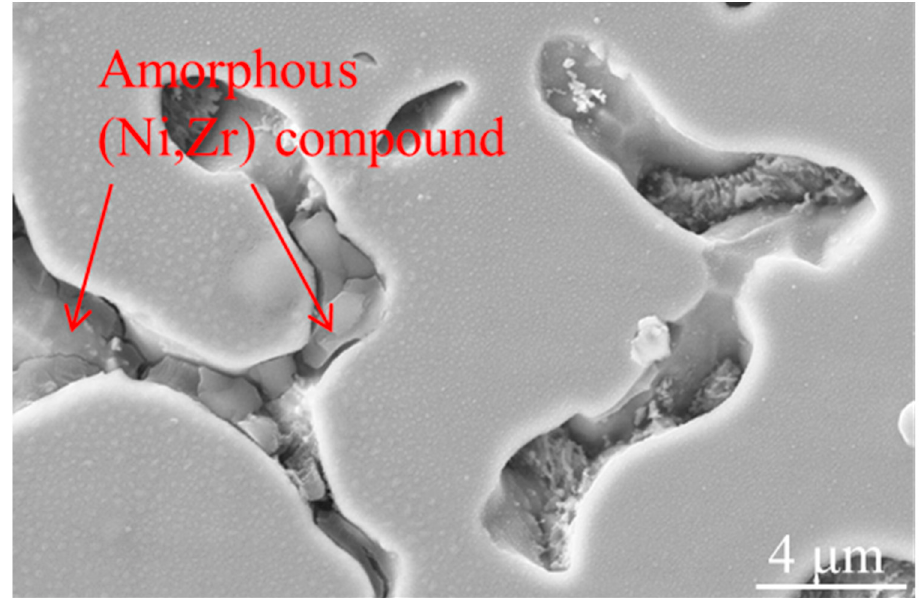
Figure 8. Amorphous (Ni,Zr) intermetallic compound at grain